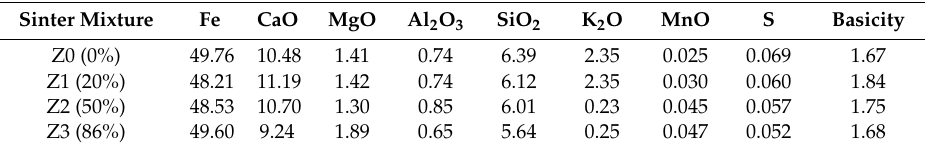
Table 5. Chemical composition (wt%) of sinter mixtures.